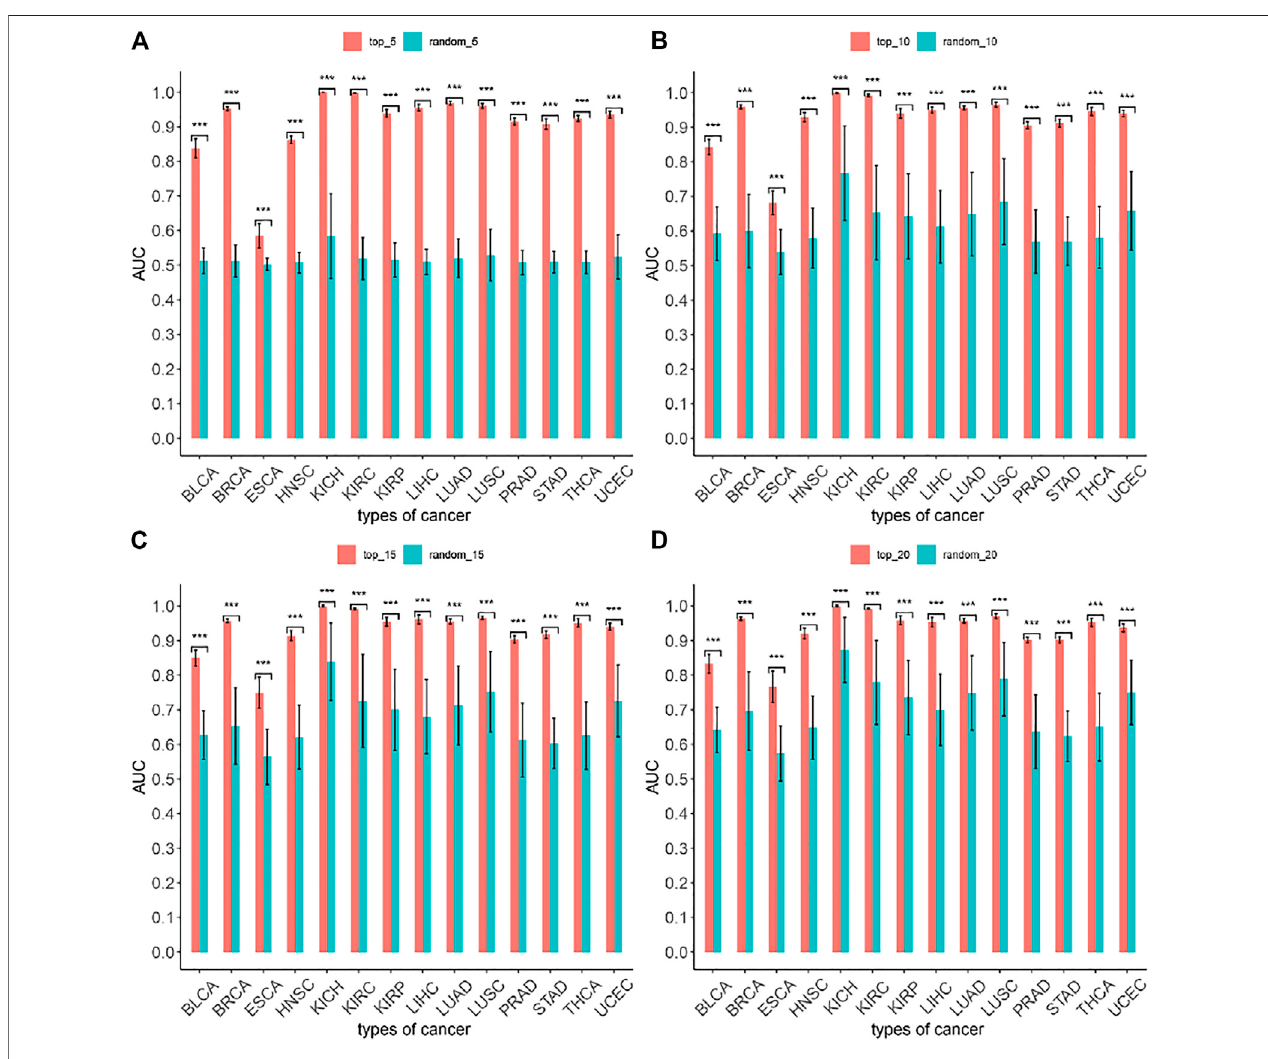
FIGURE 9 | EvaluationontheperformanceoftheMIMRDAmethodviatheRandomForestsimulationtest.Thetop-rankedmiRNAsidenti fi edbytheMIMRDAmethodare comparedwiththerandomlyselectedmiRNAs,bothafterthe fi ve-foldcross-validationRandomForestsimulations. (A) Top_5rankedmiRNAs vs random_5miRNAs. (B) Top_10 ranked miRNAs vs random_10 miRNAs. (C) Top_15 ranked miRNAs vs random_15 miRNAs. (D) Top_20 ranked miRNAs vs random_20 miRNAs. p -value < 0.001***.